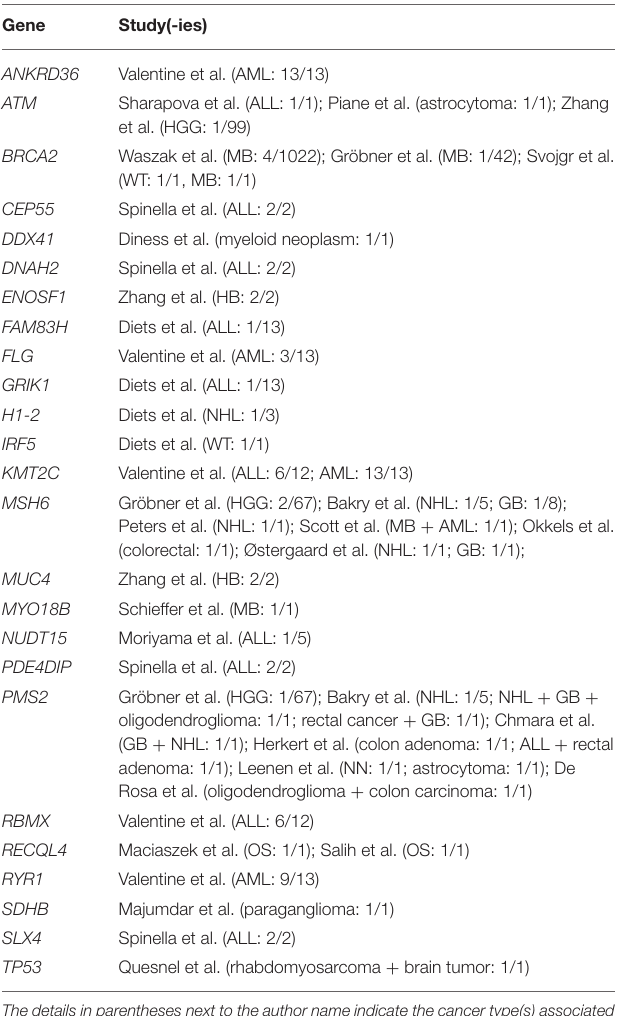
TABLE 1 | Genes with identified CH variants and the study(-ies) that identified